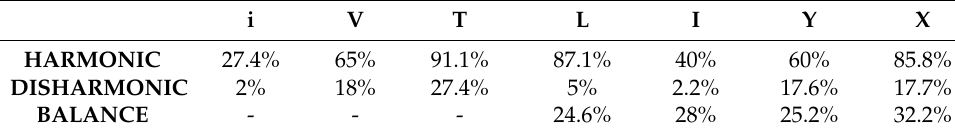
Table 2. Covered areas for each experiment related to the human avatar.